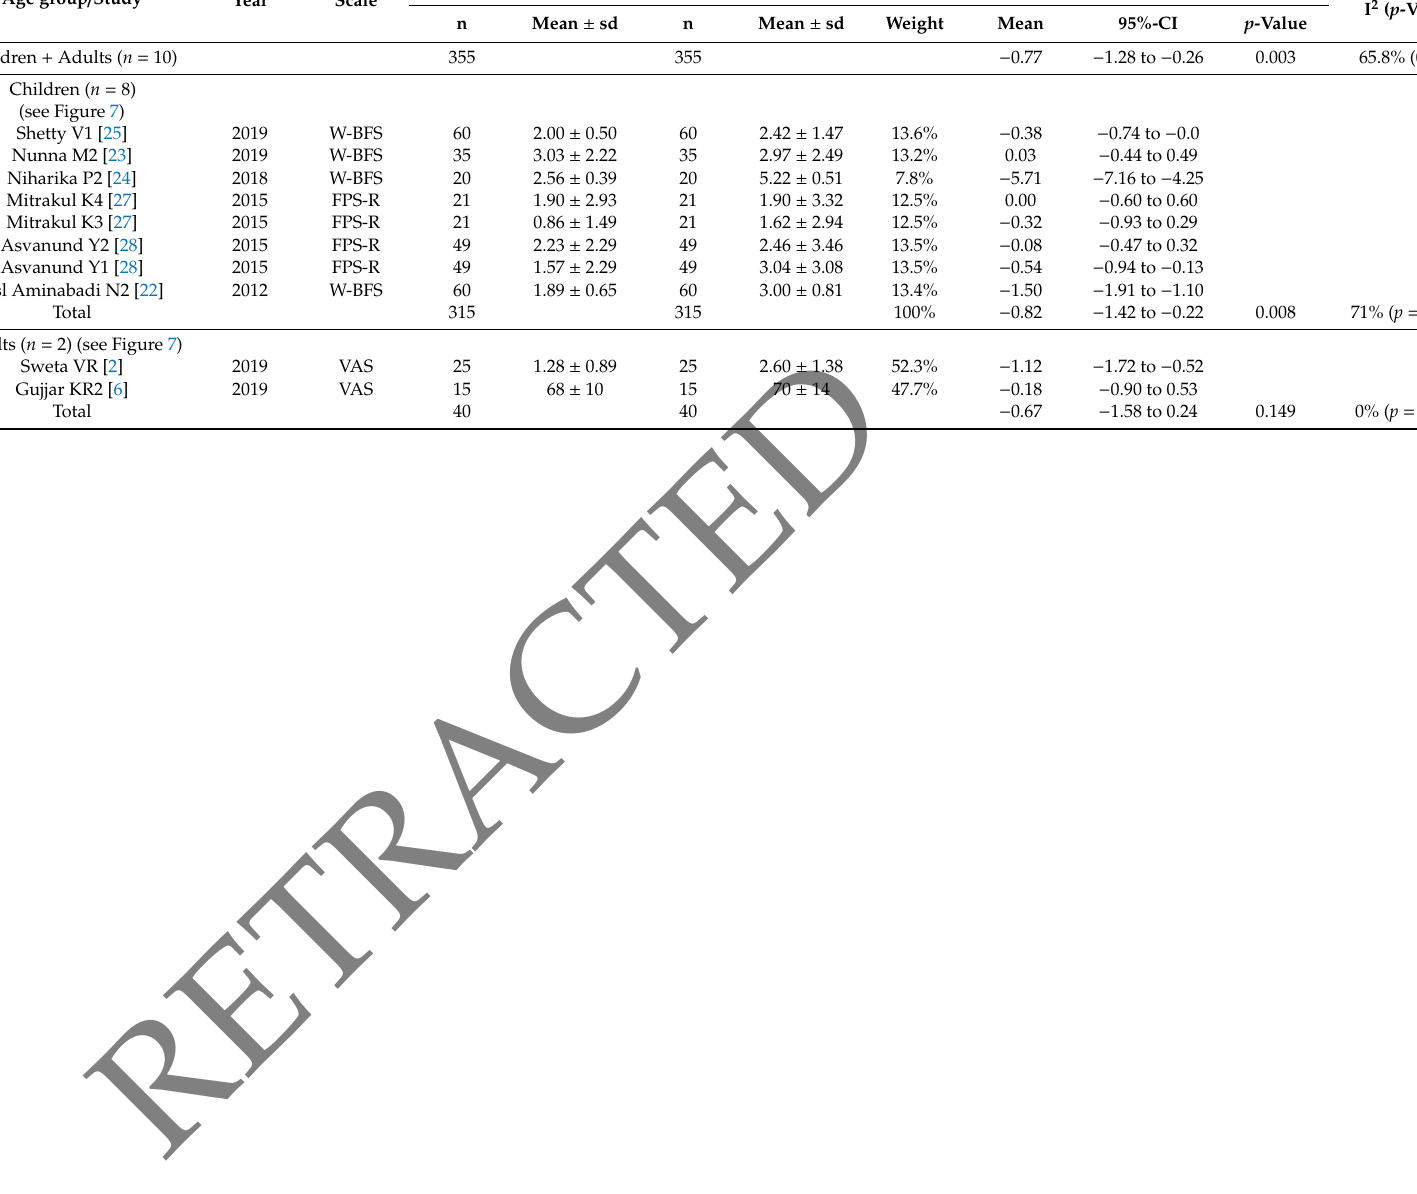
Table 4. Meta-analysis of pain according to random e ff ect models. Characteristics of individual studies and meta-analysis. a: Standardized di ff erence of means. Test Age group / Study Year Scale